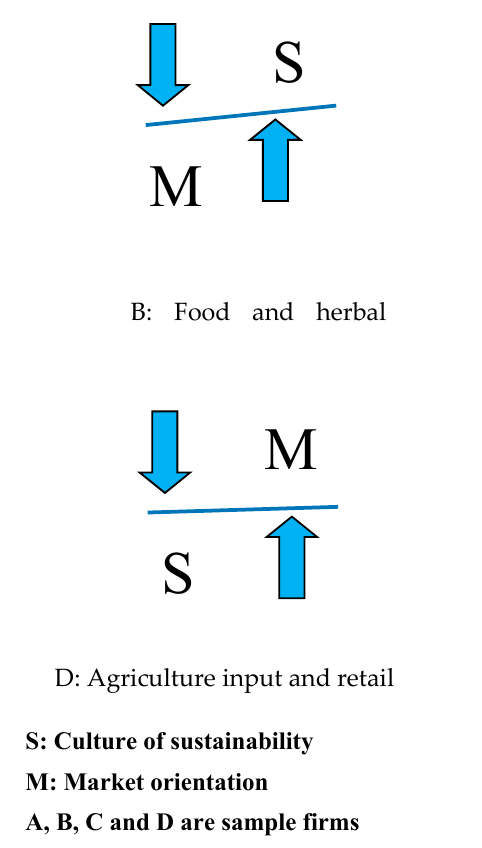
Table 2. Evidence of volunteerism as a part of organisational culture.